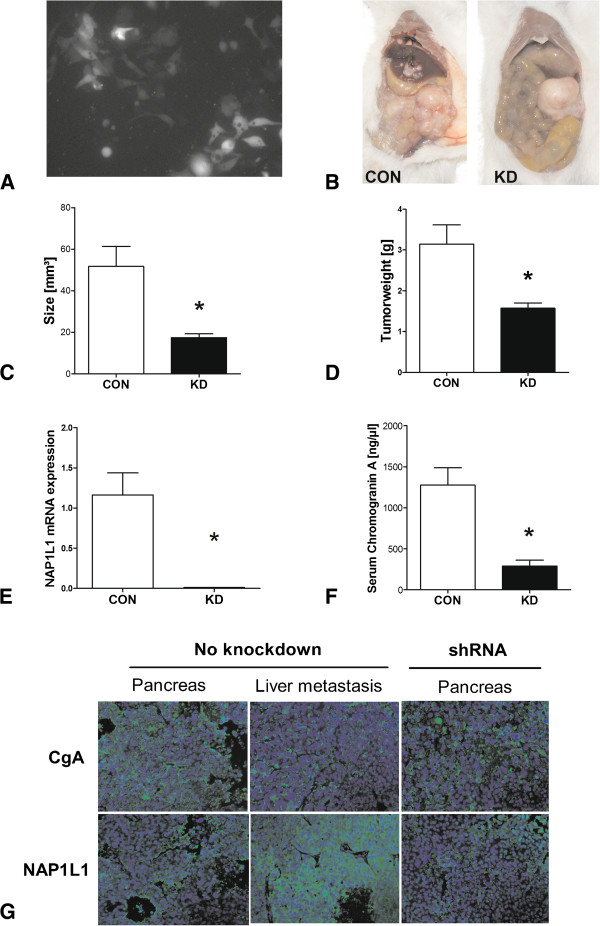
Impact of NAP1L1 silencing of tumor growth in an orthotopic pNEN mouse model. After having established stable NAP1L1 knockdown BON cells (confirmation of shRNA internalization by fluorescence microscopy (A) and thereafter puromycin-selection), we injected 1.5 × 106 transfected cells in 100 μl PBS into the pancreas tail of nine Ns/J-mice by flank-laparotomy (CON = 4 mice, KD = 5 mice). Six weeks after pancreas injection, necroscopy identify large tumors with metastases in control injected mice (B), while KD-injected mice had smaller (C) (*p < 0.05) and lighter (D) (*p < 0.05) tumors that were all localized. KD tumors expressed less NAP1L1 than controls (E and G). Circulating chromogranin A (CgA) levels were also decreased in serum of KD mice (F) (*p < 0.05), and expression of this marker was lower in the liver metastases (G). Mean ± SEM.